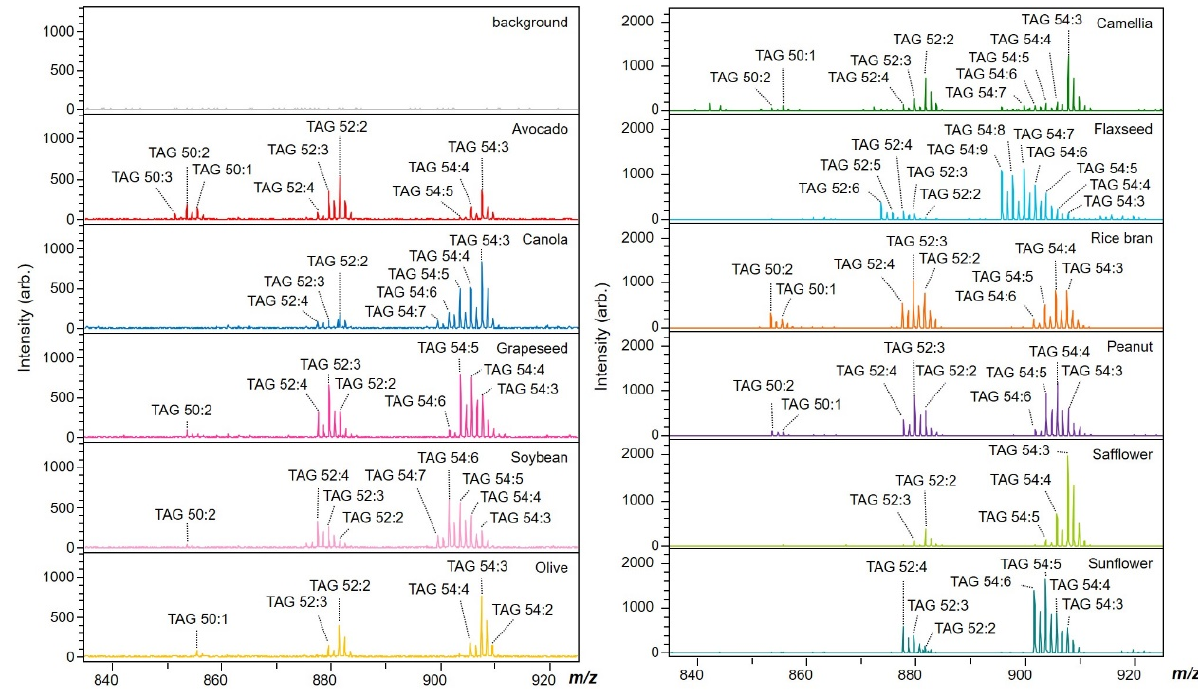
Figure 4. Mass spectra of TAG profiles obtained from various edible oils prepared using spray AgNPts in positive mode.